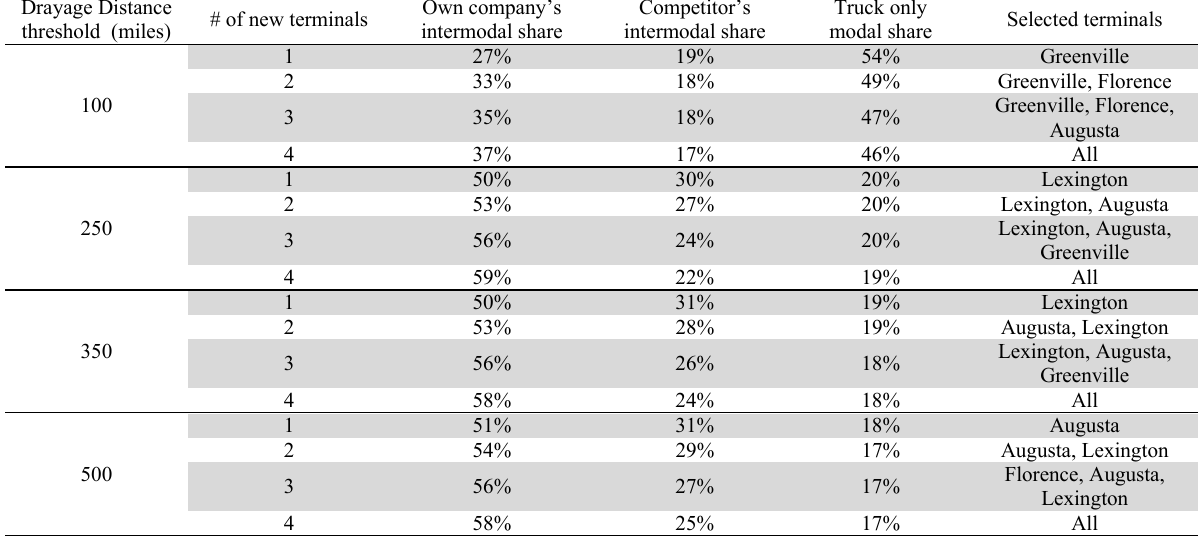
Effect of drayage distance thresholds on intermodal market shares and locations Drayage Distance threshold